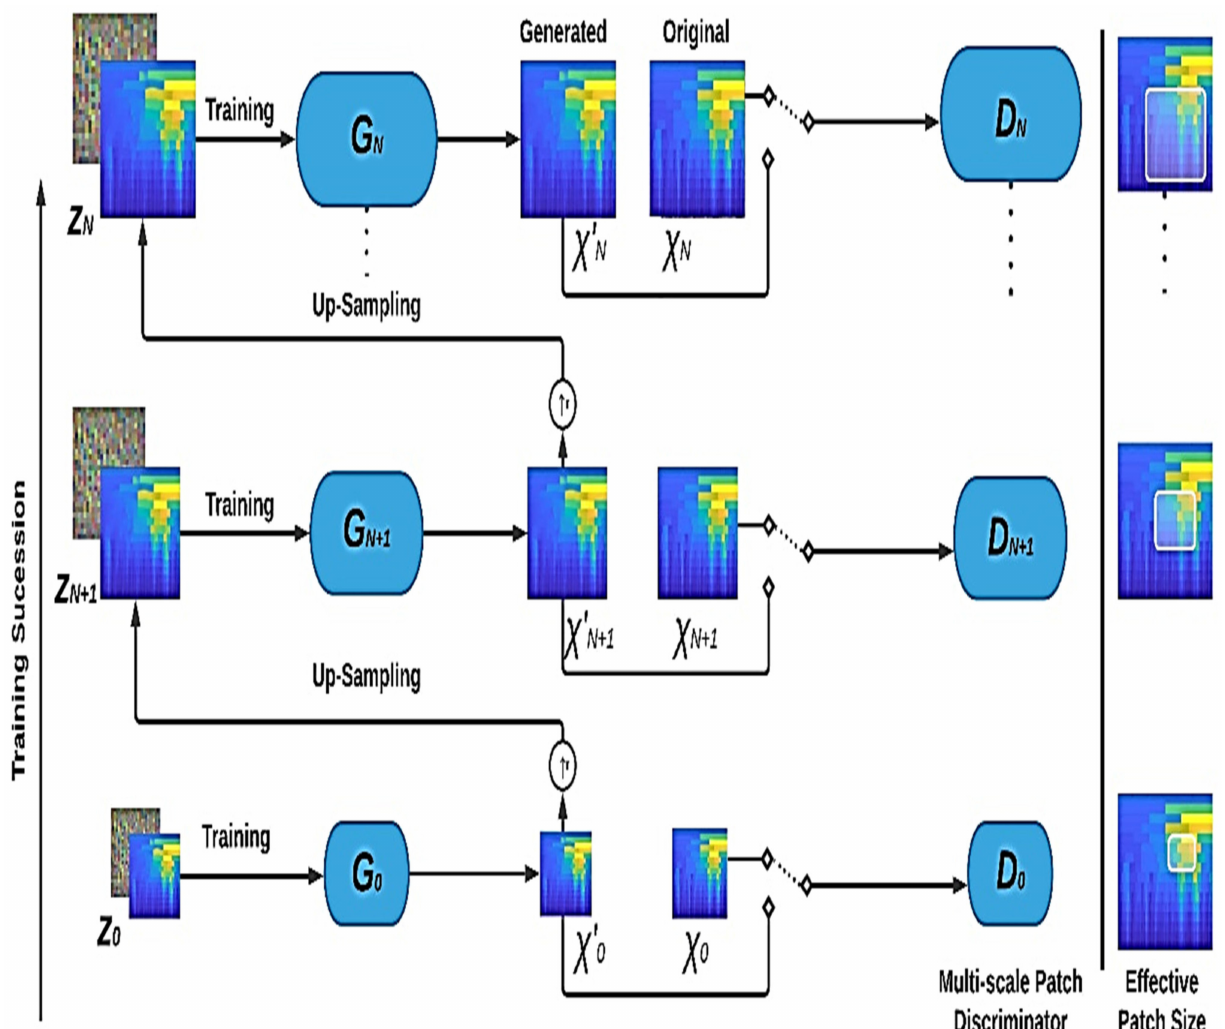
Figure 2. The architecture of single natural image Generative Adversarial